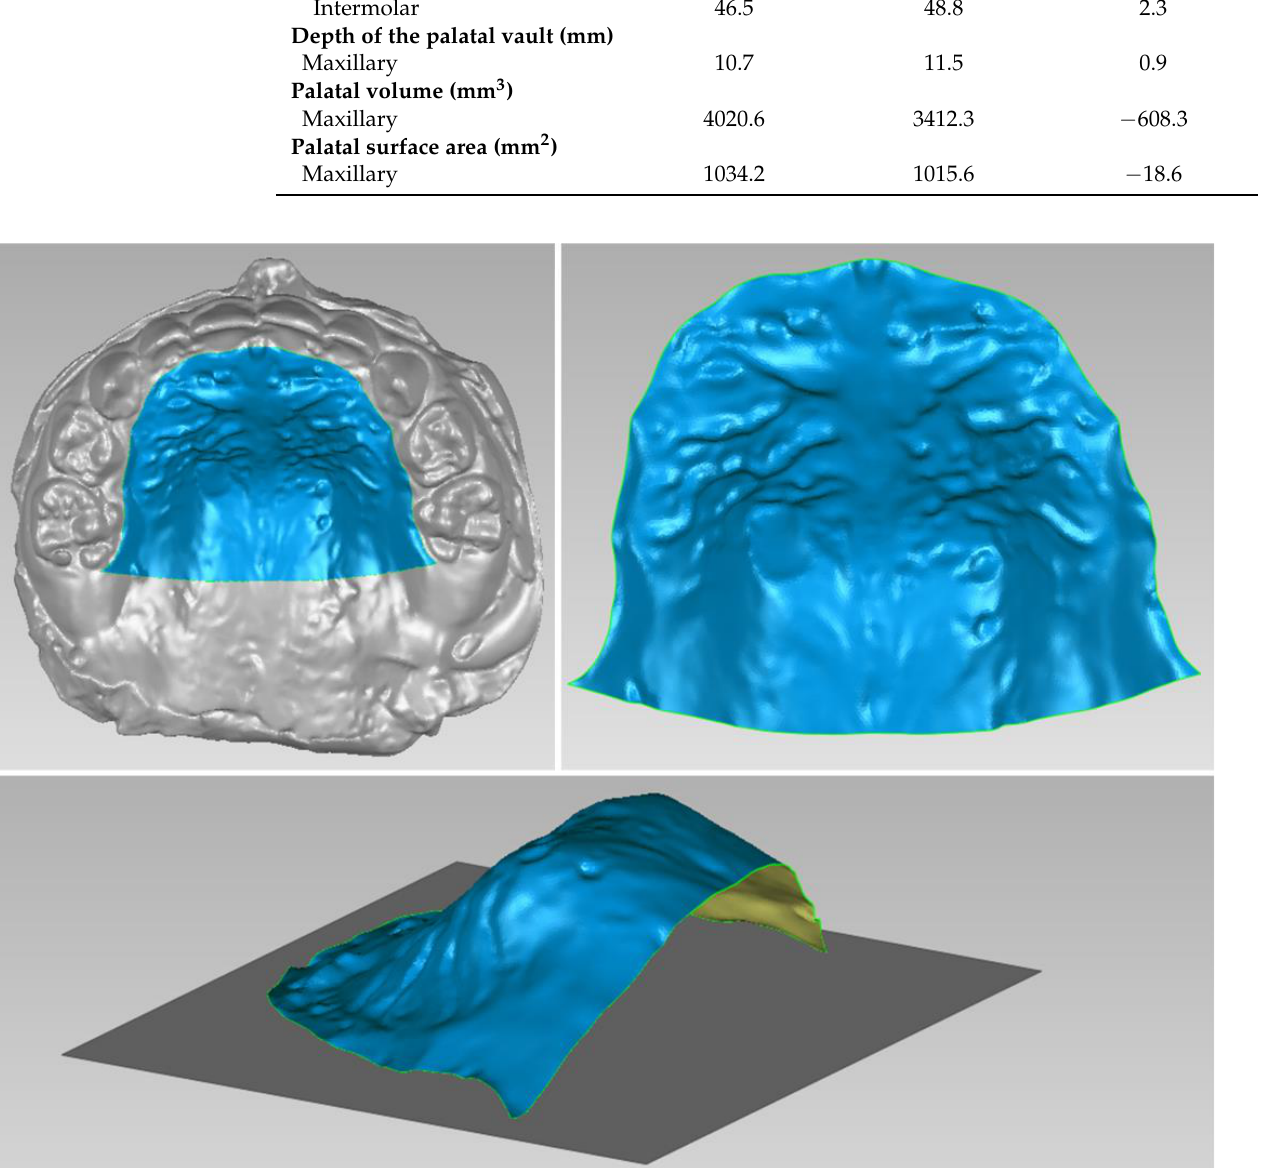
Figure 7. Digital cast measurement of the final cast.